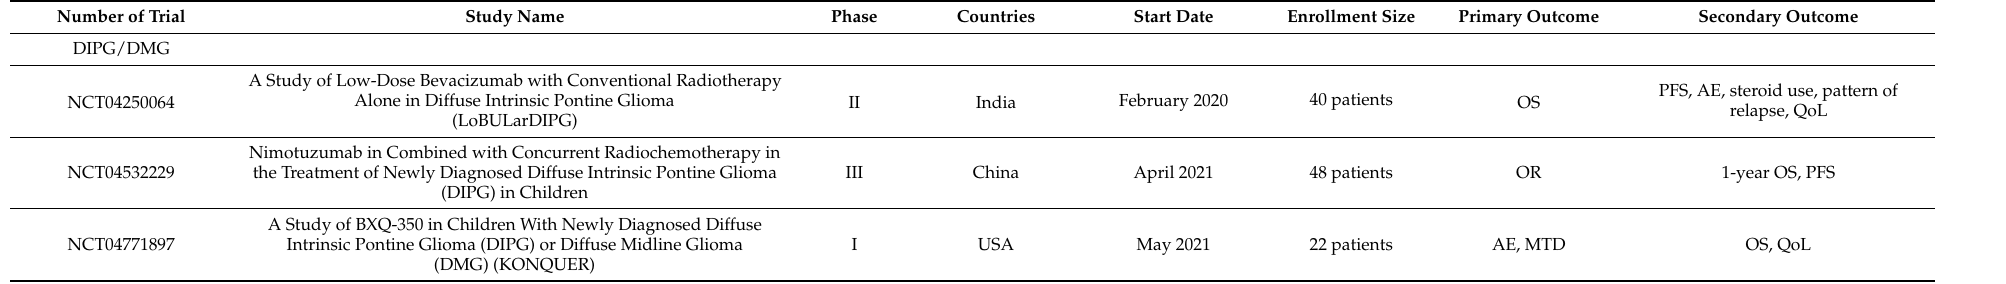
Table 3. DMG/DIPG trials still